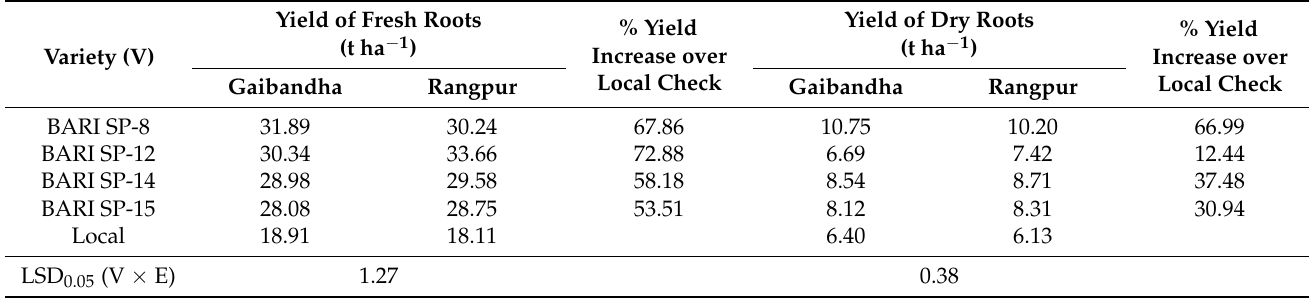
Yield of Dry Roots (t ha − 1 )